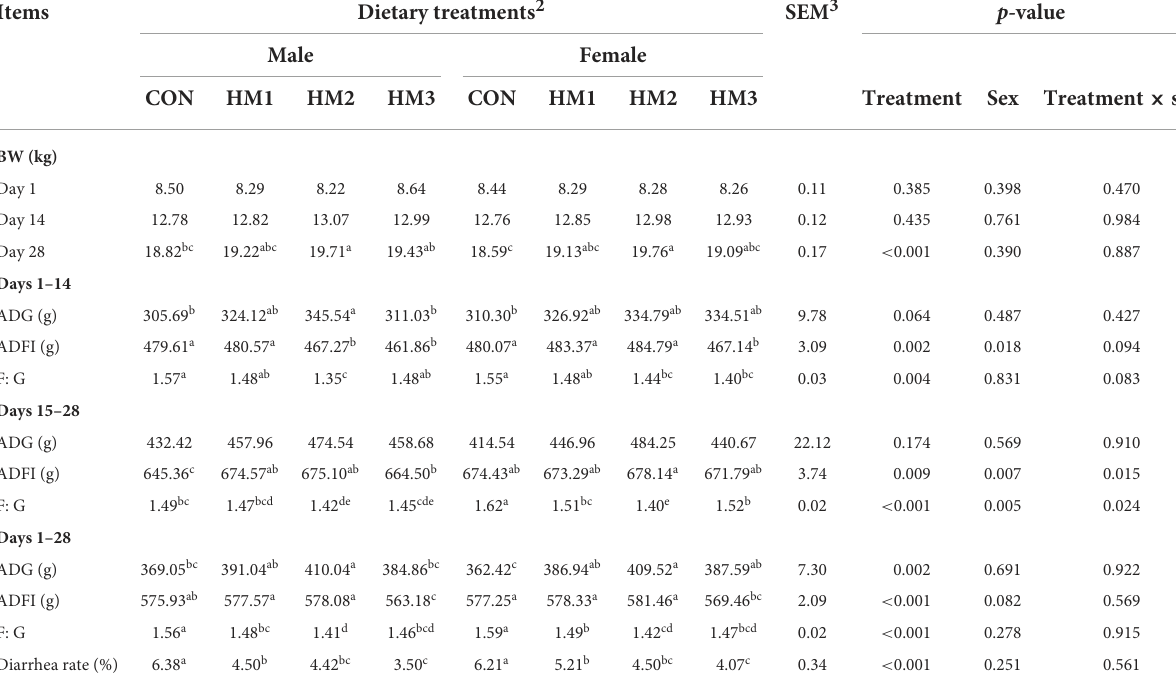
TABLE 1 Effects of herbal mixture on growth performance of weaned pigs 1